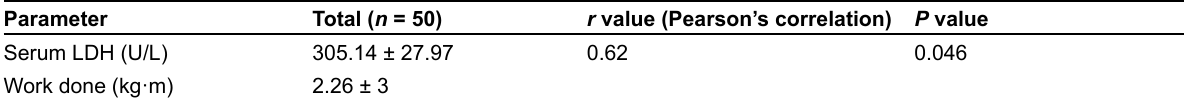
Table 4. A correlation of work done (kg·m) with serum LDH levels in prediabetic